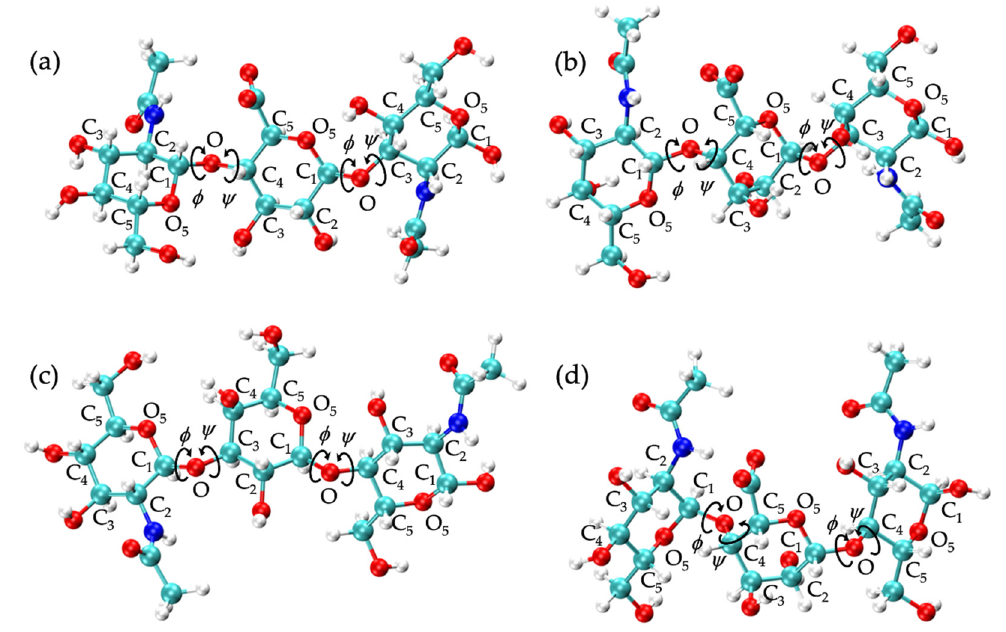
Figure 1. GAG trisaccharides: ( a ) hyaluronan [GlcNAc β 1-4GlcA β 1-3GlcNAc], ( b ) nonsulfated dermatan [GalNAc β 1-4IdoA α 1-3GalNAc], ( c ) nonsulfated keratan [GlcNAc β 1-3Gal β 1-4GlcNAc], ( d ) nonsulfated heparan [GlcNAc α 1-4IdoA α 1-4GlcNAc]; endocyclic ring atoms and oxygen atoms linking adjacent rings are labeled; arrows indicate rotations about glycosidic linkage bonds C 1 -O and O-C n (quantified by φ and ψ dihedral angles, respectively); glycosidic linkage parameters used in the construction algorithm include C 1 -O and O-C n bond lengths, O 5 -C 1 -O and C 1 -O-C n bond angles, and φ = O 5 -C 1 -O-C n and ψ = C 1 -O-C n -C ( n − 1) dihedral angles. Molecular graphics throughout are produced with the VMD program [ 90].